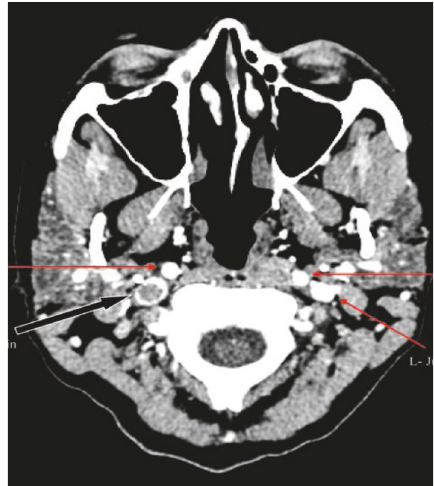
Figure 7: Computed tomographic venogram shows direct visual- ization of thrombus within the right internal jugular vein in another patient, marked by black arrow [6]. Red arrows mark normal flow voids. Reprinted from